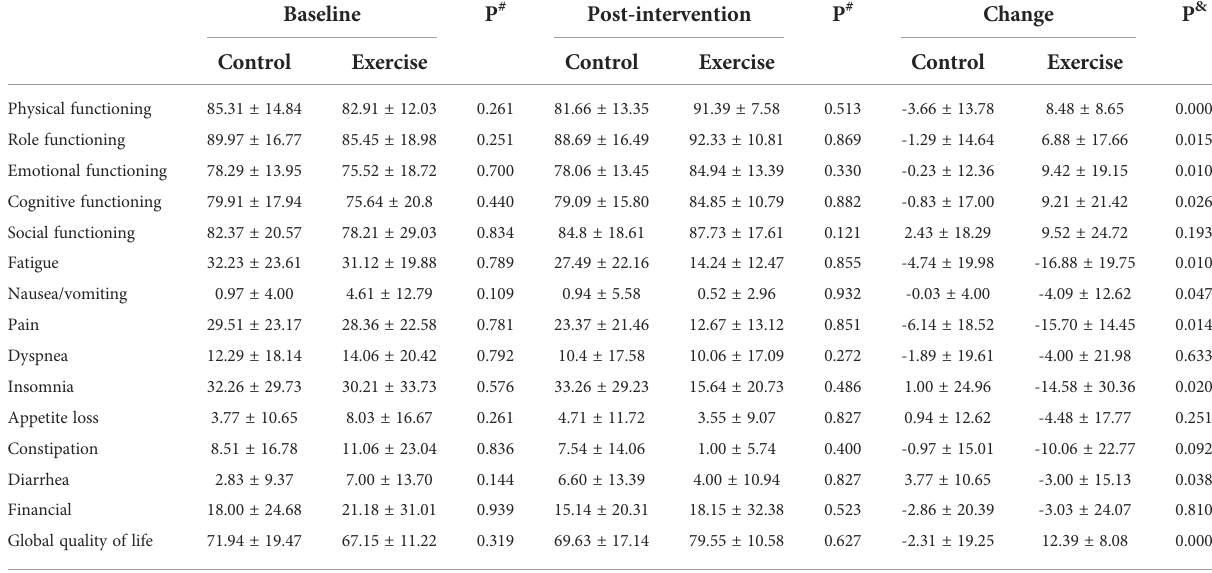
TABLE 2 Effects of Baduanjin on quality of life (EORTC